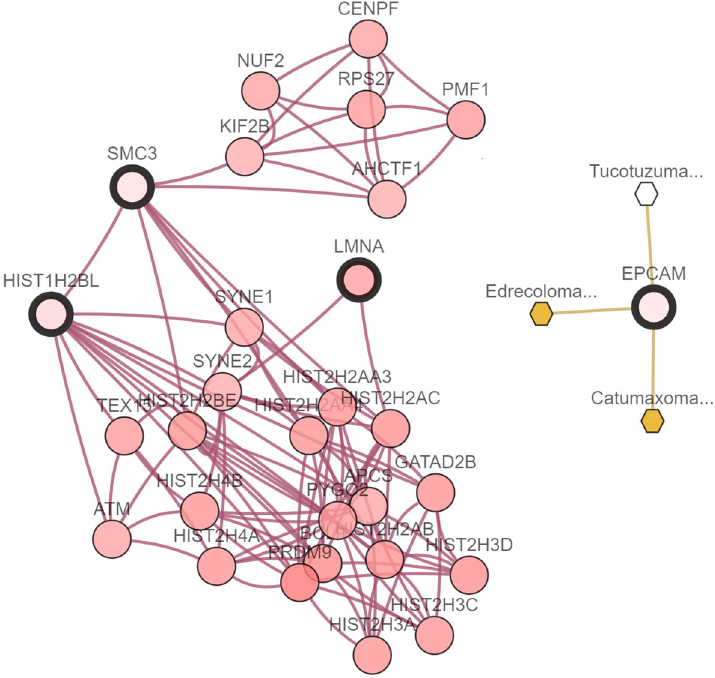
Figure 7. Maximum Integrative Network of features selected by the LogSum + L 2 penalized logistic regression model in GSE19804 dataset.